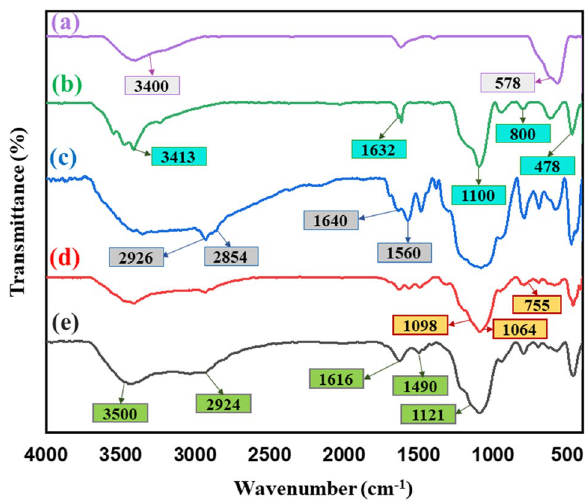
Figure 2. FT-IR spectra of ( a ) Fe 3 O 4 MNPs, ( b ) Fe 3 O 4 @SiO 2 MNPs, ( c ) Fe 3 O 4 @SiO 2 @APTMS MNPs, ( d )